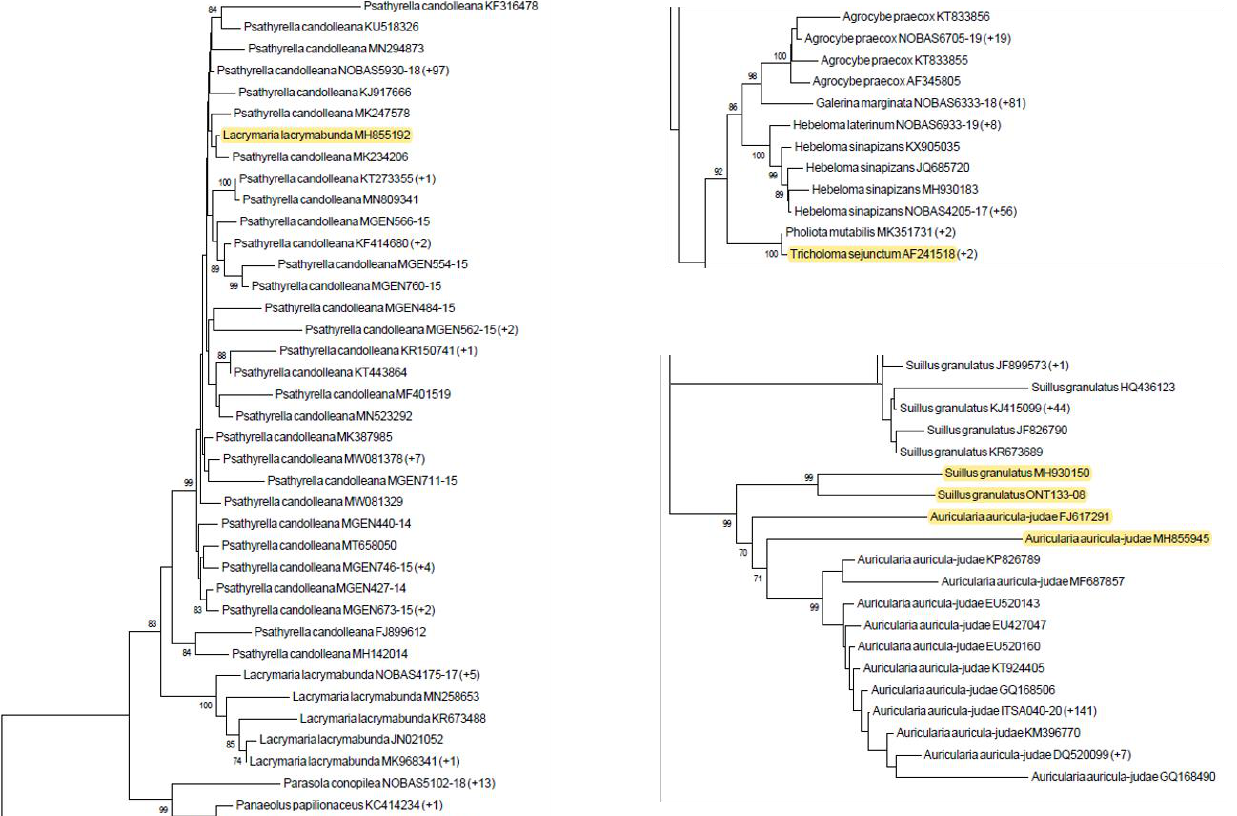
Figure 2. Three sections of the Neighbor Joining (NJ) phylogram constructed using the Kimura 2 parameter model [42] with 1000 bootstrap replicates on ITS sequences maintained after the first filtering step. Examples of sequences which clustered separately from the respective species/genus with bootstrap values ≥ 70% (highlighted in yellow) were therefore removed from the dataset. In brackets, the number of ITS sequences presenting an intra-species variability < 0.01 with respect to the indicated sequence is reported.